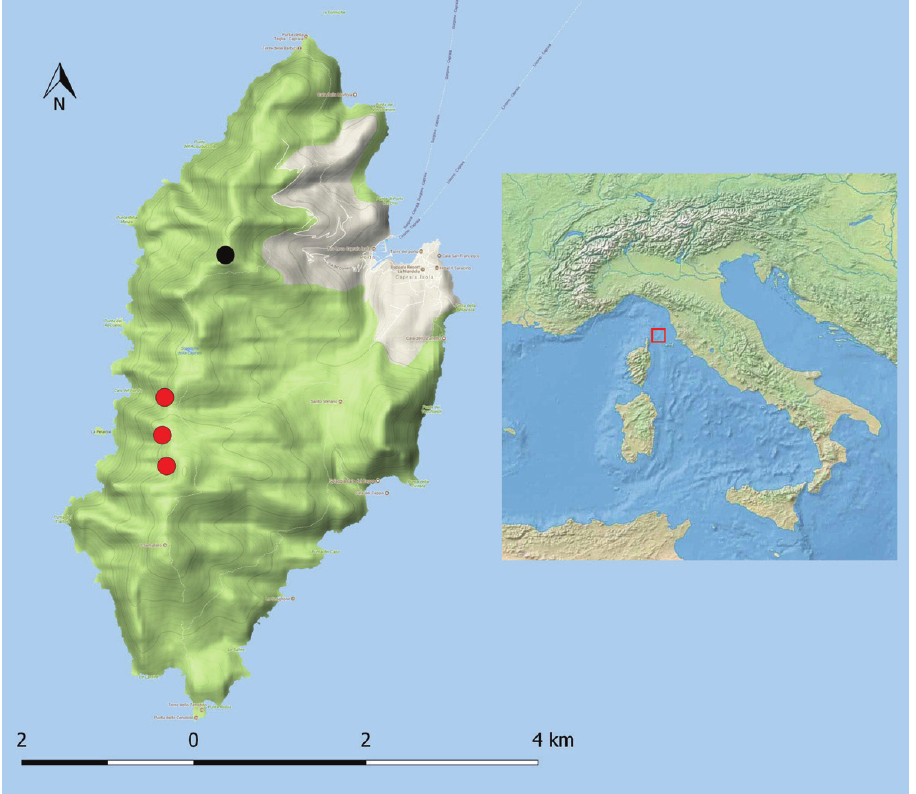
Figure 2. Geographic range and distribution map of Saxifraga caprariae . The red points in the map mark the current localities of occurrence, while the black one indicates an historical